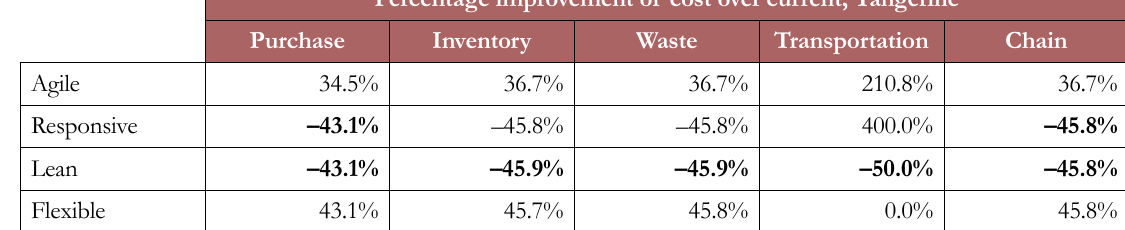
Table 9c. Percentage Change cost for